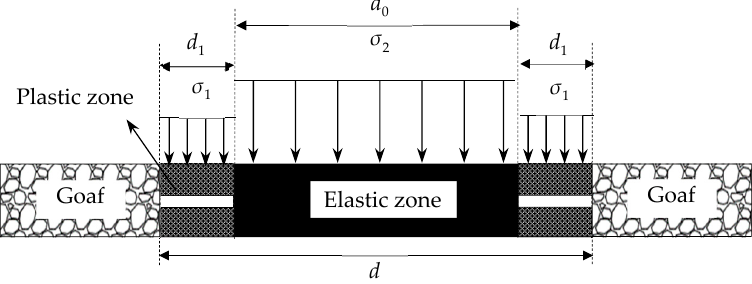
Figure 8. Calculation model of average stress of the ICP.